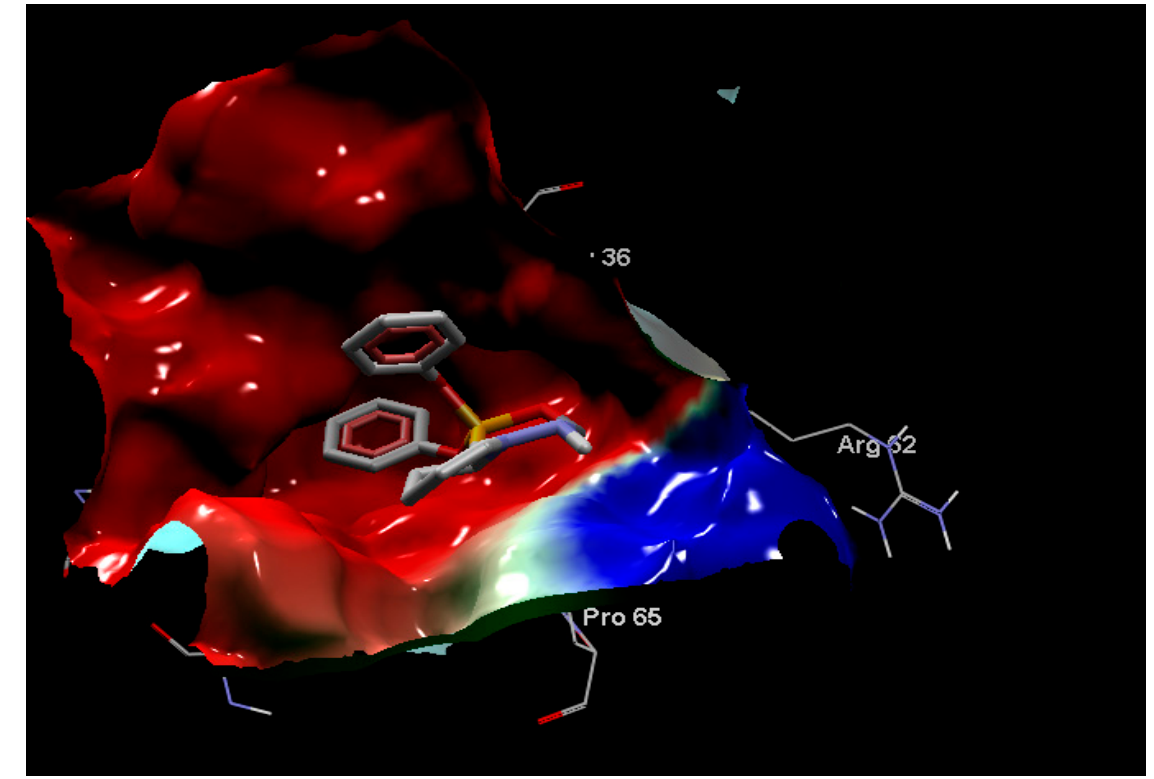
Figure 9. The second view represents the electrostatic interactions of 2a -gyrase B complex. The second view displays the electrostatic charges, red surface refers to the negative charge while blue surface is the positive charge and the inhibitor 2a is colored according to the atom type (carbon atom is dark gray, oxygen atoms are red while phosphorus is dark yellow and nitrogen for violet).